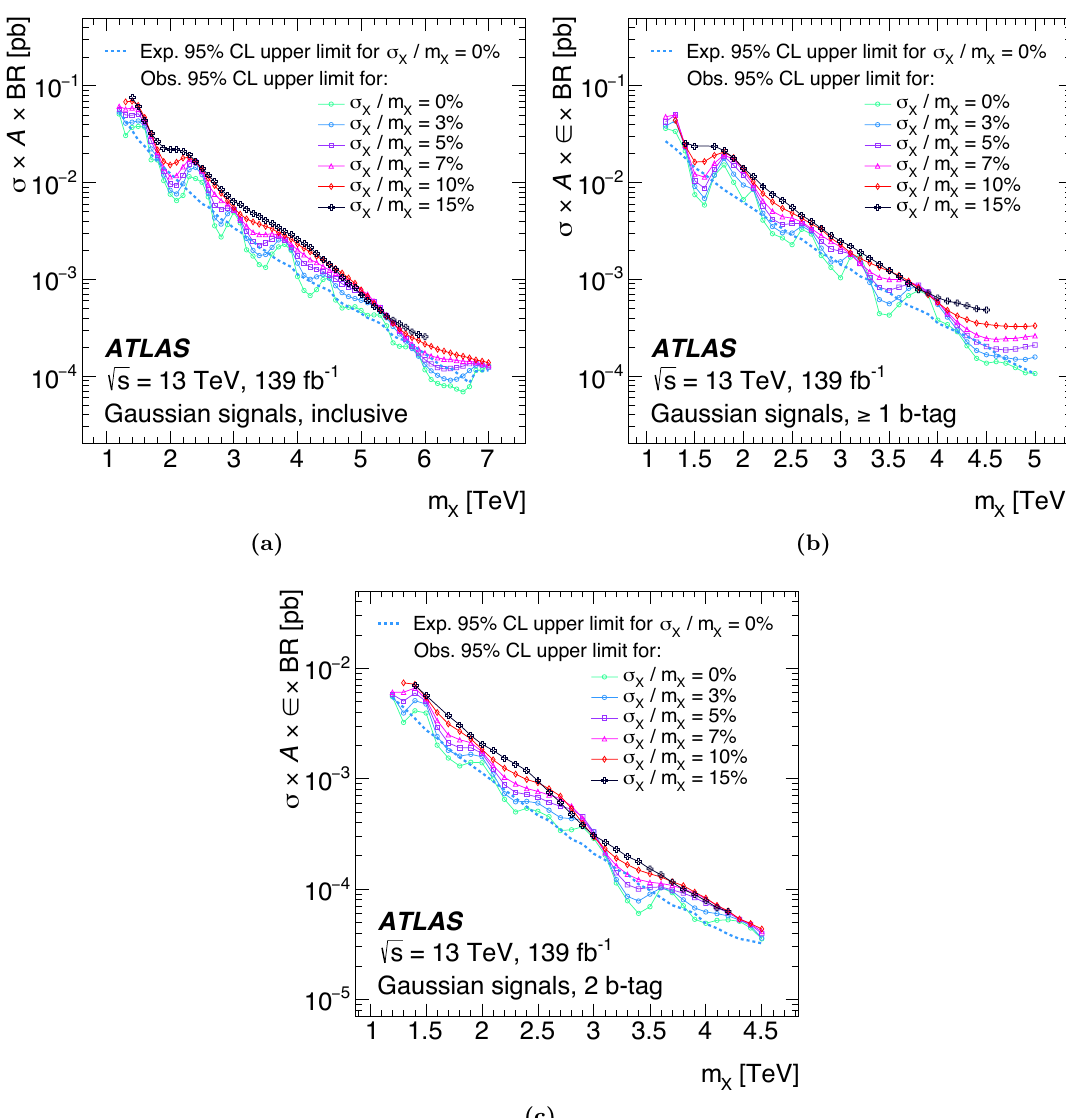
Figure 8 . The 95% CL upper limit on the cross-section times kinematic acceptance times branching ratio for resonances with a generic Gaussian shape, as a function of the Gaussian mean mass m in the (a) inclusive, (b) 1 b and (c) 2 b categories. For the limits with one or two b -jets the b -tagging e(cid:14)ciency is included. Di(cid:11)erent widths, from 0% up to 15% of the signal mass, are considered. Gaussian-shape signals with 0% widths correspond to signal widths smaller than the experimental resolution. For a Gaussian-shaped signal with a relative width of 15%, the limits are truncated at high mass when the broad signal starts to overlap the upper end of the m